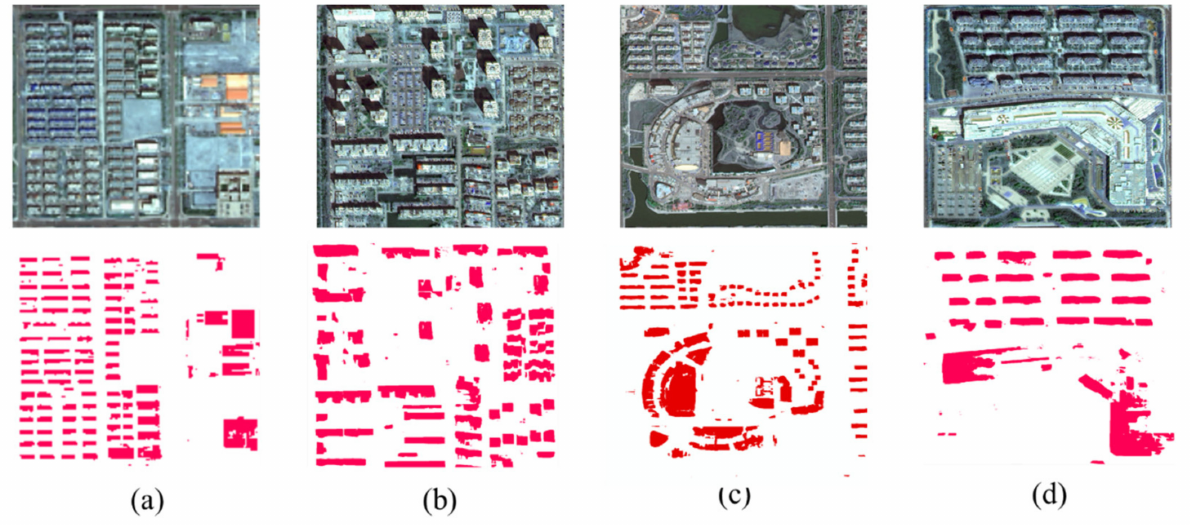
Figure 10. Building extraction results: ( a ) buildings in the residential estate, ( b , c ) mid-rise and high-rise buildings, ( d ) larger